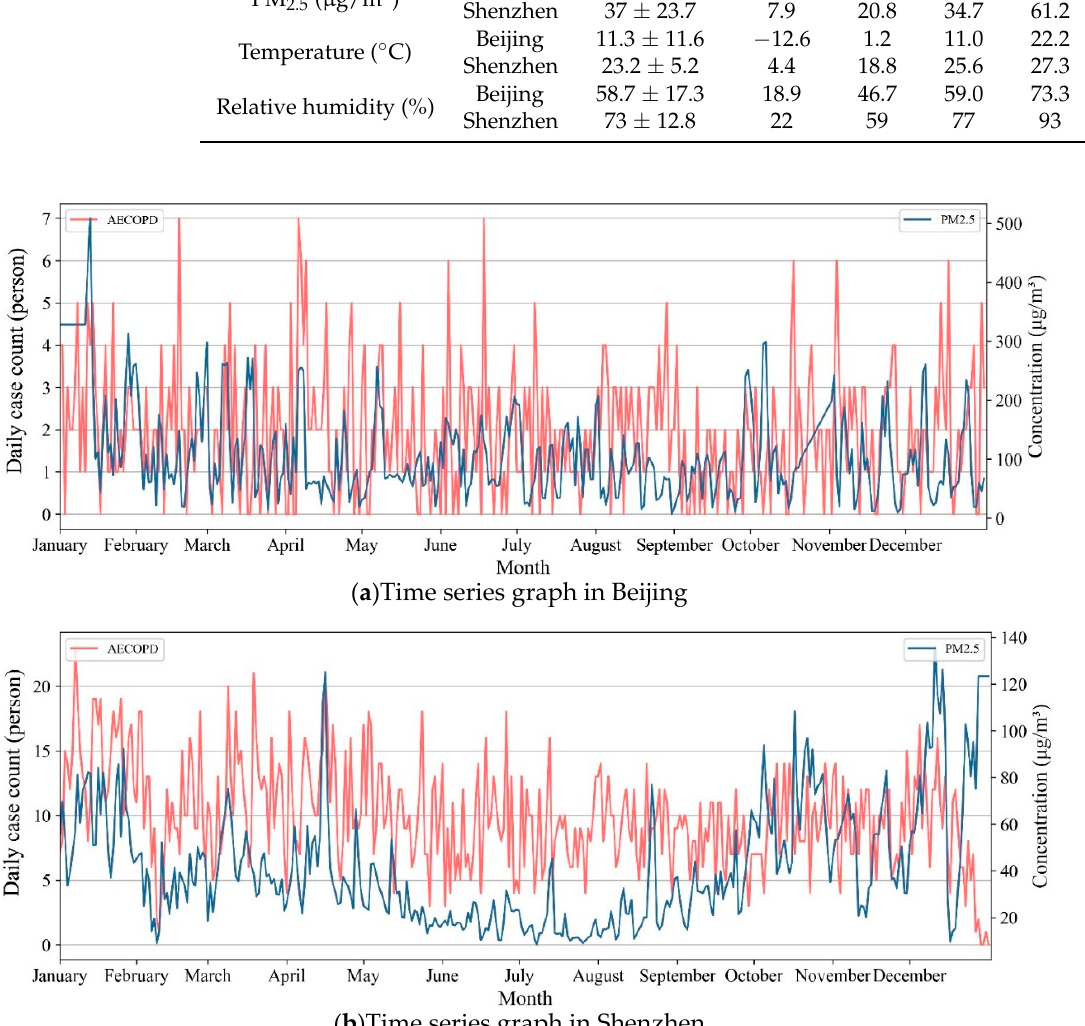
Figure 2. Time series graph of AECOPD (count of daily cases) and daily PM 2.5 concentrations in ( a ) Beijing and ( b ) Shenzhen in 2013.